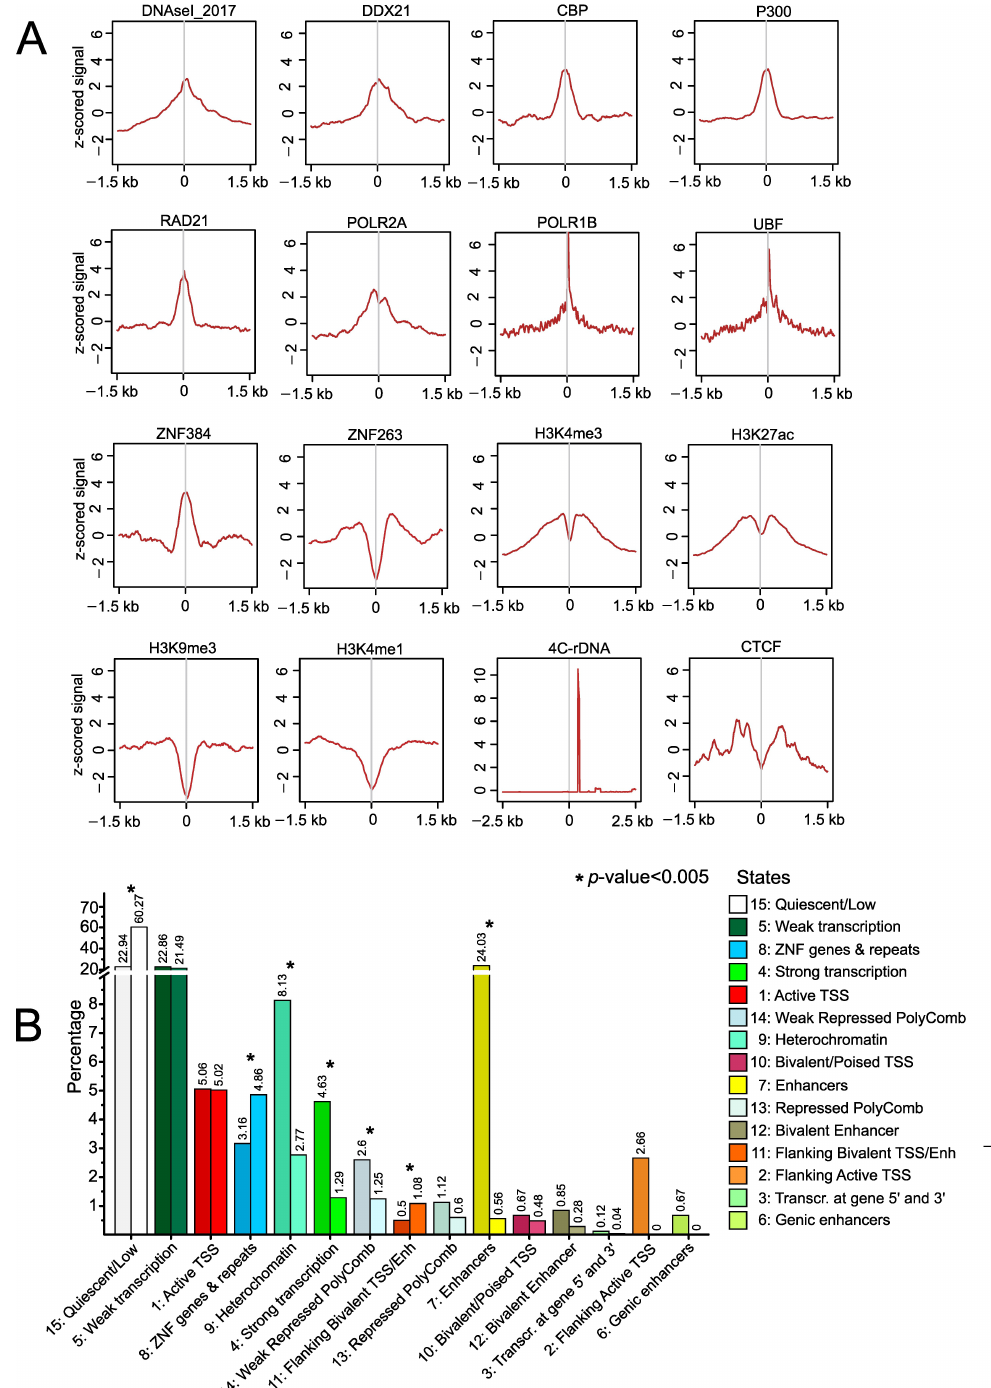
Figure 3. Properties of srRNA targets in HEK293T cells. ( A ) Profiles of DNase I sites, binding sites of different factors, histone marks, and rDNA-contacting sites around srRNA targets. The z-scored signals ±1.5 kb around srRNA targets are indicated. ( B ) The percentage of chromatin states (15-state model) in H1-derived neuronal progenitor-cultured cells in the whole genome (left dark bars) and at srRNA targets (right light bars) is shown. The color codes of the epigenetic states are shown in the order they appear at the srRNA sites. The labels present a state number and the percentage of the corresponding state. The statistical significance of the difference between epigenome states is tested with the independent-samples unequal-variances t-test. All cases with statistically significant differences ( p < 0.005) are marked by an